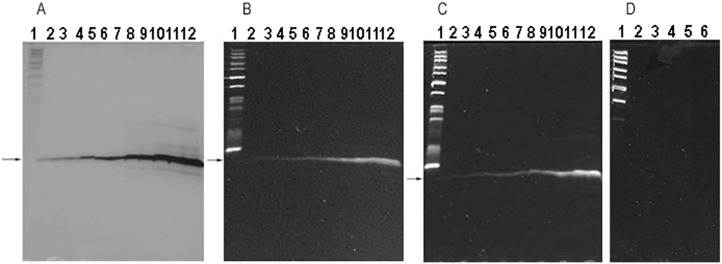
Oligo A11 in 15% denaturing PAGE gels.DNA marker was DNA marker 1 (GeneRuler™ Ultra low Range DNA ladder, Fermentas, Lithuania). The arrows indicate the specific oligo bands. (A), (B) and (C) The gels were stained with silver, SGRGS and GDD, respectively. Lane 1 was DNA marker 1. Lanes 2–12: 0.01, 0.02, 0.04, 0.06, 0.08, 0.1, 0.2, 0.4, 0.6, 0.8 and 1μg of oligo A11. (D) The gel was directly stained with GDD without fixing the gel before staining. Lane 1 was DNA marker 1. Lanes 2–6: 2, 4, 6, 8 and 10 μg of oligo A11.